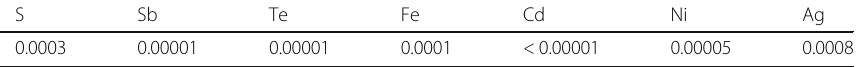
Table 1 Chemical composition of OFHC Cu (wt%)